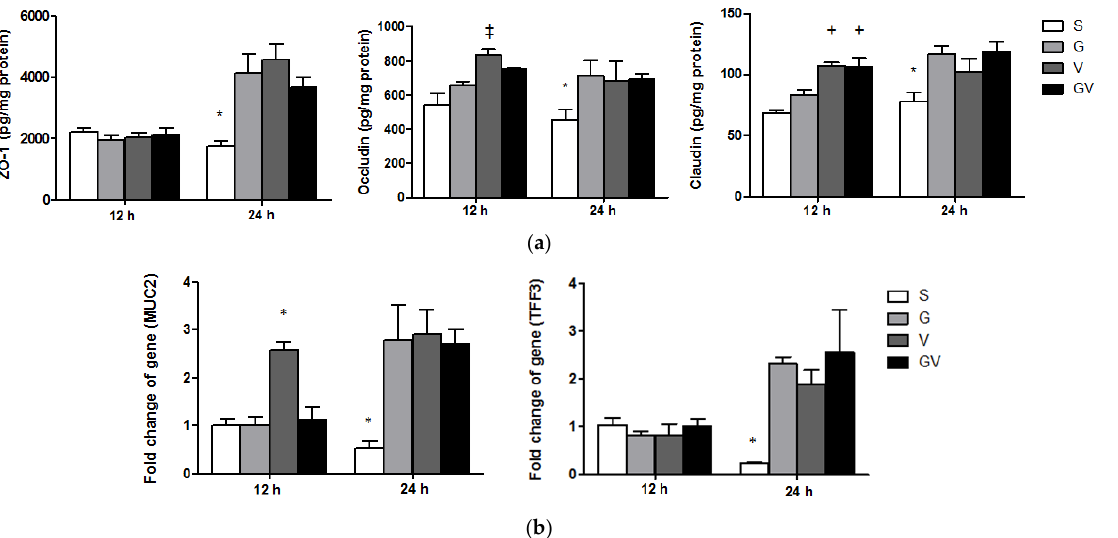
Figure 7. ( a ) Tight junction protein levels and ( b ) mRNA levels of mucins in ileum tissues after cecal ligation and puncture at two time points. ZO-1, Zona occludens-1; Muc2, mucin 2; Tff3, trefoil factor 3. mRNA changes were quantitated and analyzed by real-time PCR and were calculated by the comparative CT (2 −ΔΔCt ) method. mRNA expression levels in the S group were used as a calibrator. The groups are described in the legend of Figure 1. Data are shown as the mean ± SEM (n = 8 for each group). Differences among groups at the same time point were analyzed by a one-way analysis of variance using Tukey’s post hoc test. * Significantly differs from the other groups at the same time point. + Significantly differs from the S and G groups at the same time point. ‡ Significantly differs from the S group at the same time point ( p <